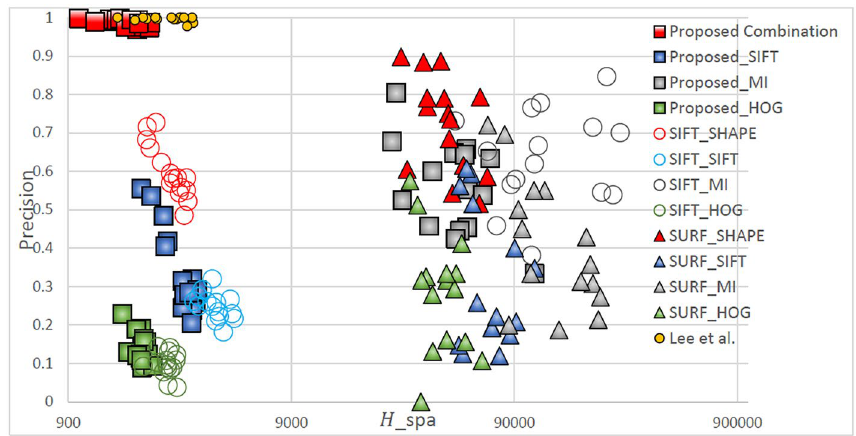
Figure 5. Quantitative comparison of matching in TYPE I through different matching combinations.